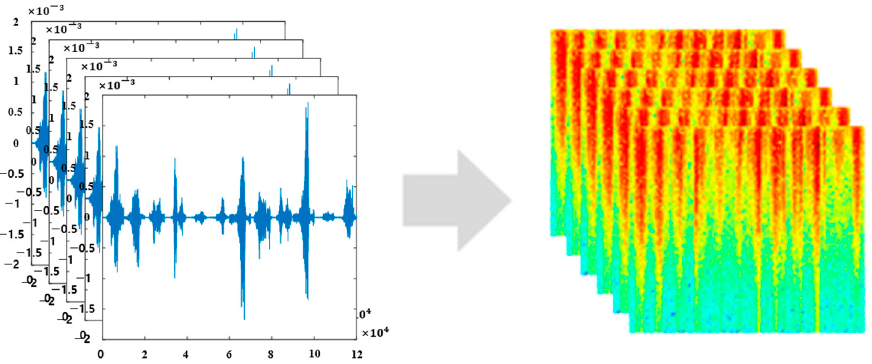
Figure 8. Transformation of sEMG signal into spectrogram.